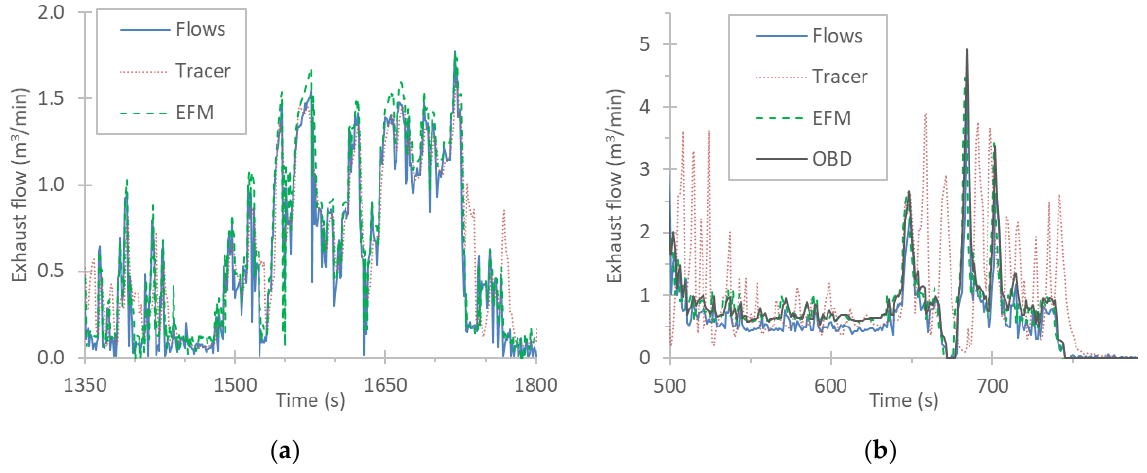
Figure 8. Exhaust flow rate measurements: ( a ) part of a WLTC with the Gasoline Euro 4 (G4) vehicle; ( b ) part of RDE_D with the Diesel Euro 6 (D6) vehicle.